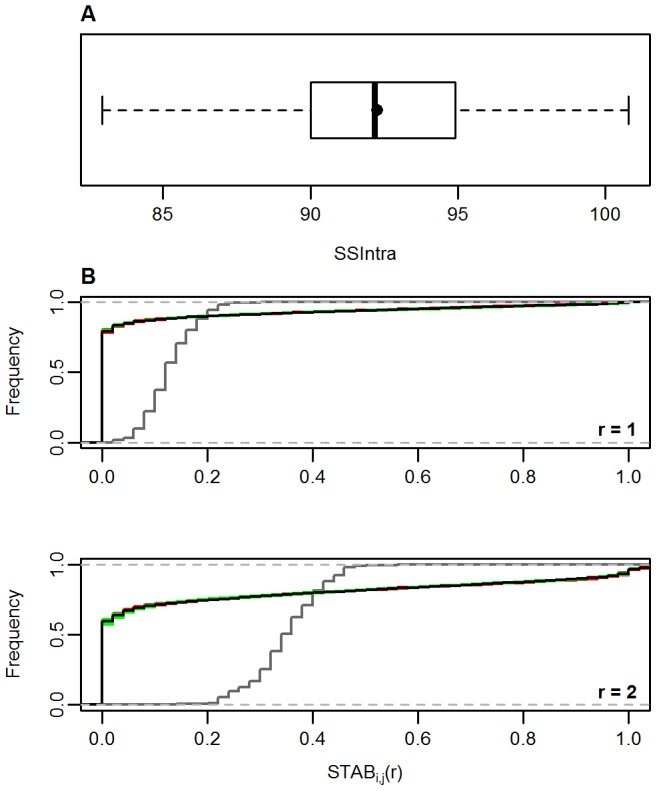
Outlier sensitivity test.A) Quantization stability: variation of the average SSIntra among 270 LOO subsets. The black dot indicates the mean. The absence of outlier values of CV(SSIntra) and the similar mean and median should be noted. B) Stability of neighbourhood relations: Histograms of the stabilities over all pairs of observations. In red, histograms of the LOO subsets in which the left-out sample was assigned to a single-neuron cluster. In green, histograms of the remaining LOO subsets. In black: histogram of the whole data set. It should be noted that there is hardly any difference between them. In grey, theoretical histogram of a randomly distributed map, following a binomial distribution defined according to de Bodt et al. [44]. This demonstrates that the SOM results are organised in a far from random distribution.